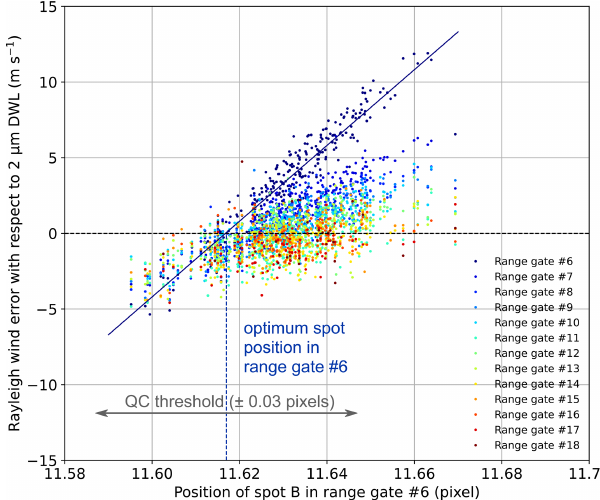
Figure 6. A2D Rayleigh wind speed difference with respect to the 2µm DWL (i.e. wind error) in dependence on the horizontal posi- tion of spot B for the AVATARI underflight on 16 September 2019. The scatters are colour-coded according to the A2D range gate. An optimum spot position is determined from those wind results in the near field (range gate no. 6; blue scatters) for which the wind error is zero. Measurements for which the spot position in range gate no. 6 deviates from the optimum by more than 0.03 pixels are filtered out by the